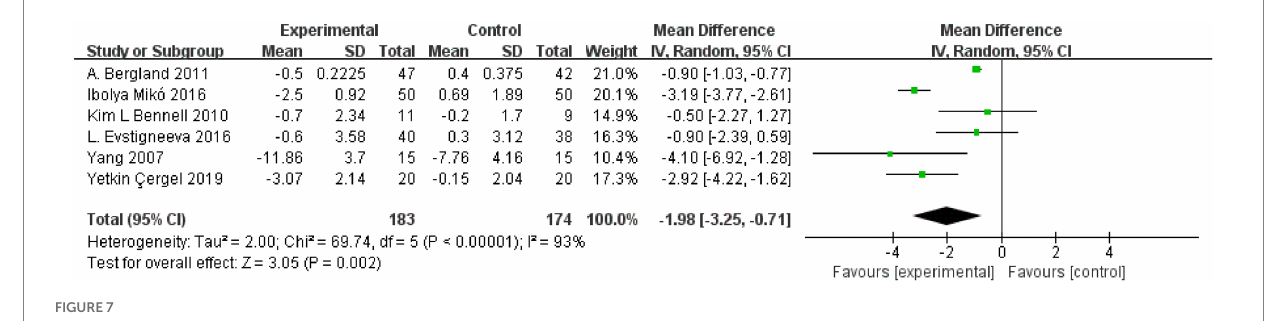
FIGURE 7 Forest plot for Timed Up and Go (TUG).